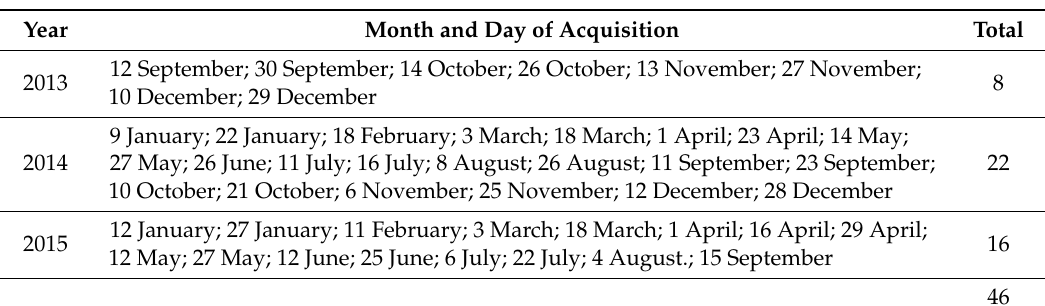
Table 2. List of periodic GPS